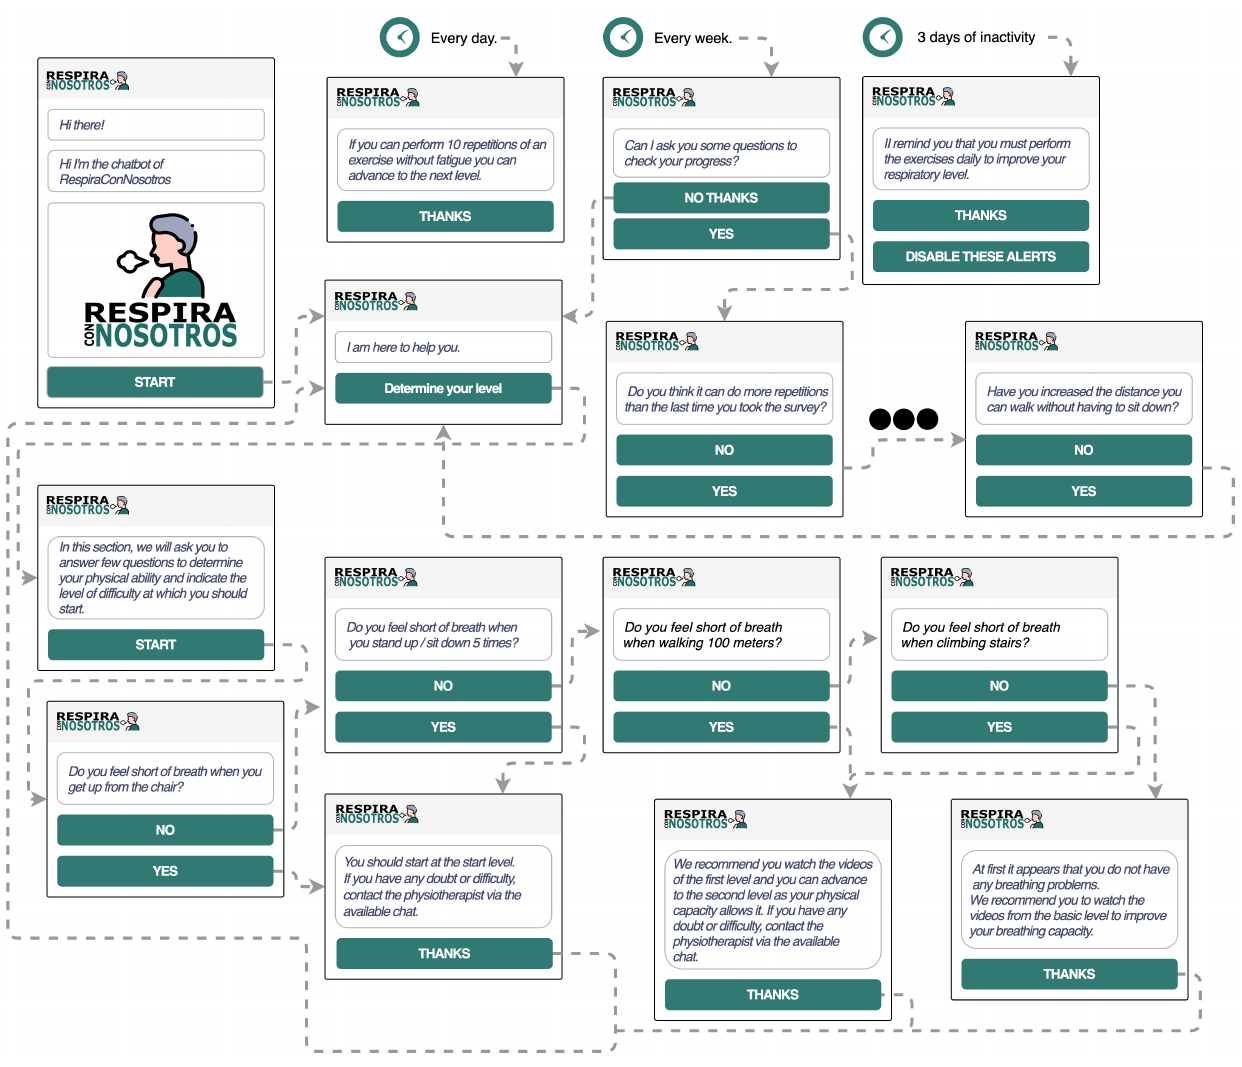
Figure 4. Chatbot